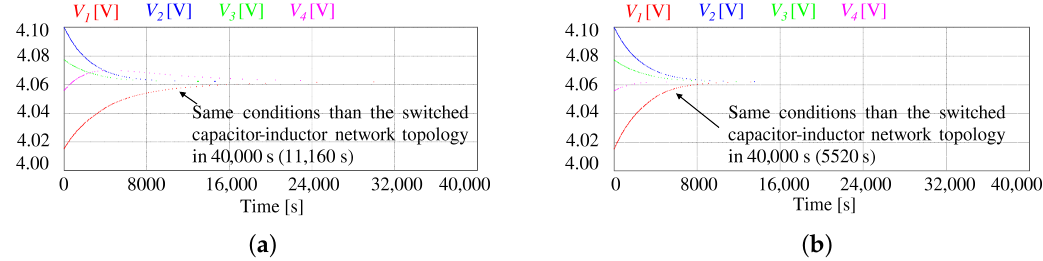
Figure 31. Multiple-tiered switched capacitor–inductor network topology: ( a ) double-tiered equalizer; ( b ) triple-tiered equalizer.